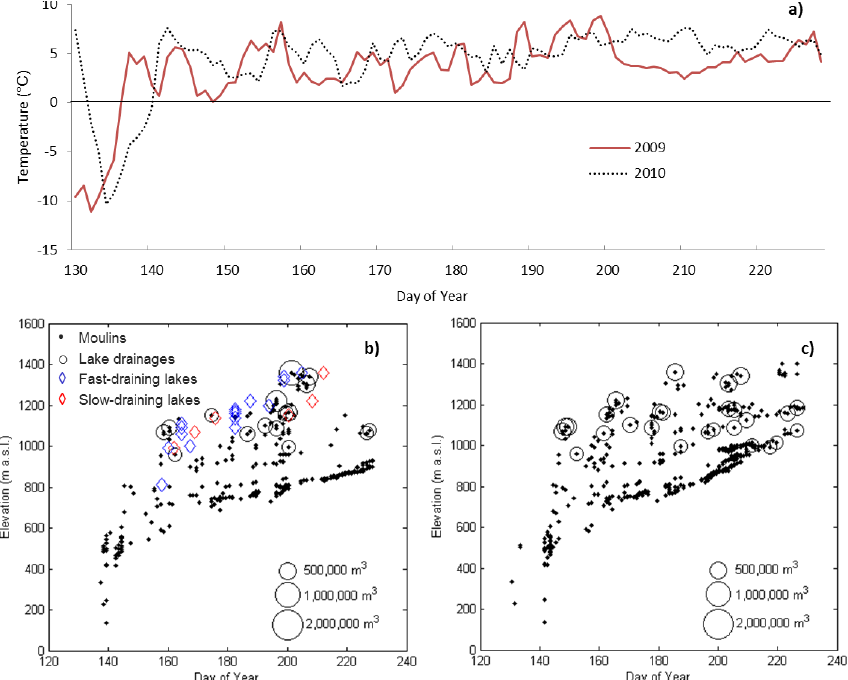
Figure 3. (a) Daily average air temperatures at site 1 (457ma.s.l.) for 2009 and 2010, and moulin formation and lake drainage through the (b) 2009 and (c) 2010 melt seasons with elevation. Blue diamonds in (b) represent observed drainage of lakes in events between two MODIS images, and red diamonds represent lakes which drained over a period of several MODIS images; after Fig. 2a of Bartholomew et al.